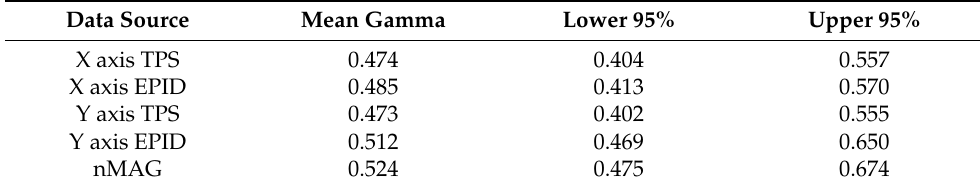
Table 1. Gamma evaluation results of experimentally (CT read out) obtained dose profiles.